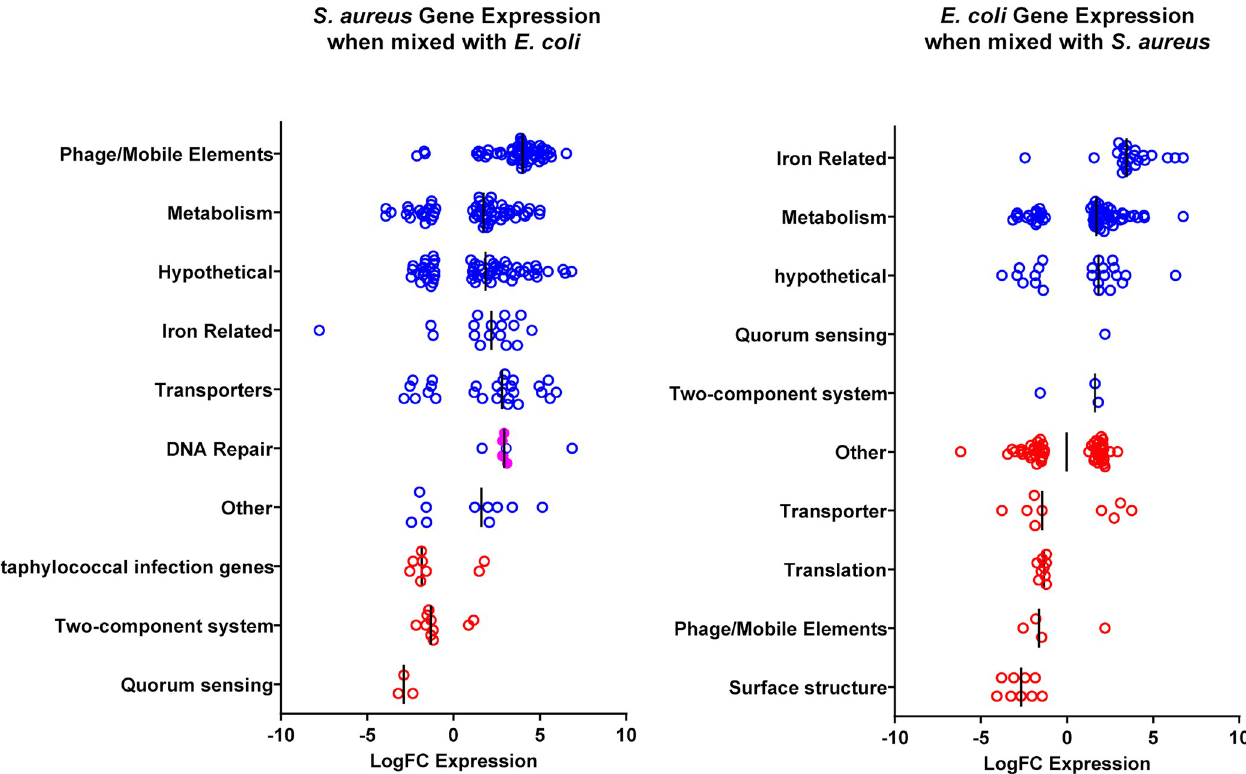
Fig 2. Co-culture of E . coli and S . aureus promotes differential gene expression. Transcription comparison between single species S . aureus strain HG001 or E . coli strain UTI89 macrocolonies and mixed species macrocolonies (1EC:1SA) after 6 h incubation, a time point at which sufficient live S . aureus could be recovered. Vertical black lines represent median values for each gene category. Each circle represents a gene that is differentially regulated (p < 0.05, FDR < 0.05) in the mixed species macrocolony compared to the single species macrocolony in the respective functional categories, with blue color indicating a functional category where the median value shows increased expression in the mixed species macrocolony and red color indicating decreased expression. Closed magenta circles represents recA and uvrAB genes. Data represent � 2 biological